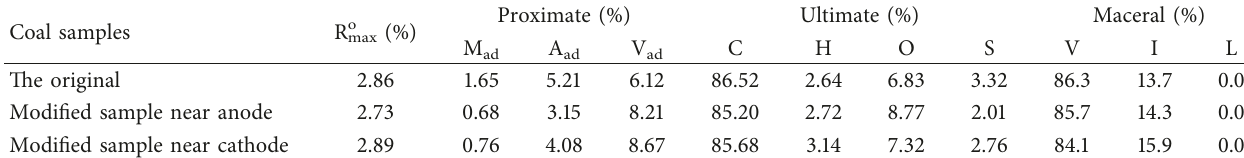
Table 1: The proximate, ultimate, and maceral composition of anthracite.